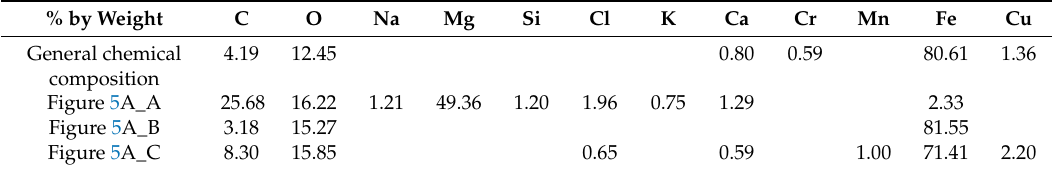
Table 6. SEM-EDS analysis of as-received oxy-cutting fines.